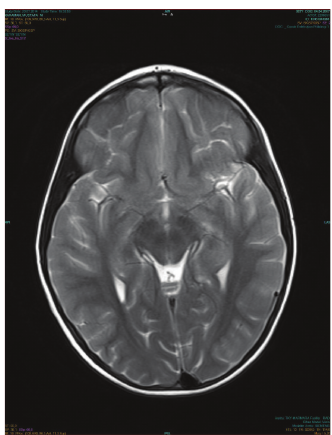
Figure 2: Improvement with a markedly decreased contrast enhancementslocalizedtotheinsularcortexandfrontallobe,aswell as the disappearance of hypothalamic